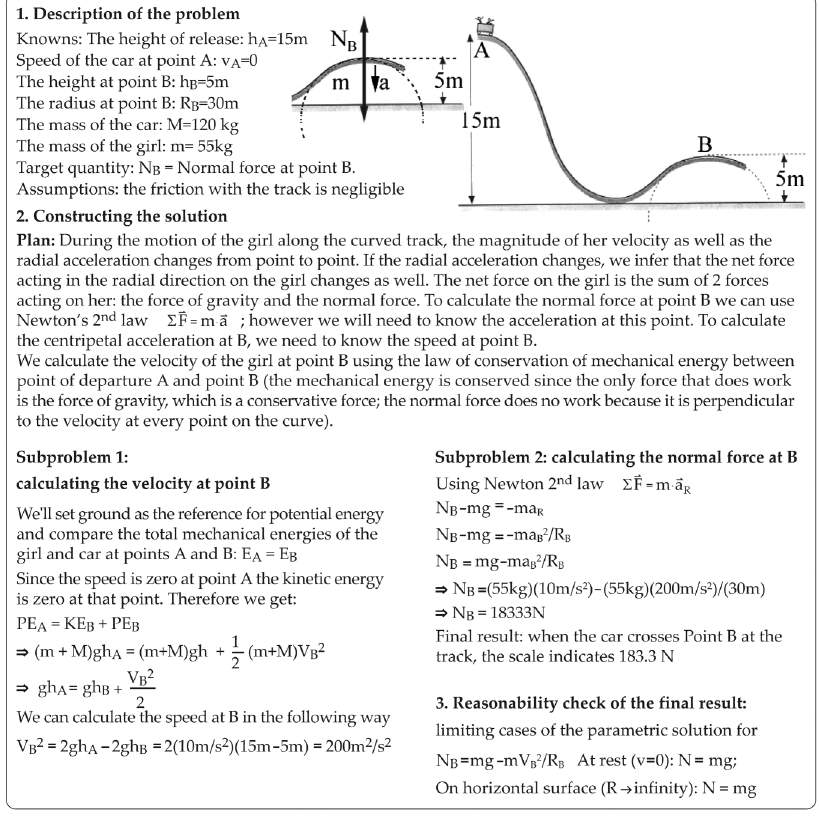
FIG. 4. Worked-out example for the pre problem, aligned with